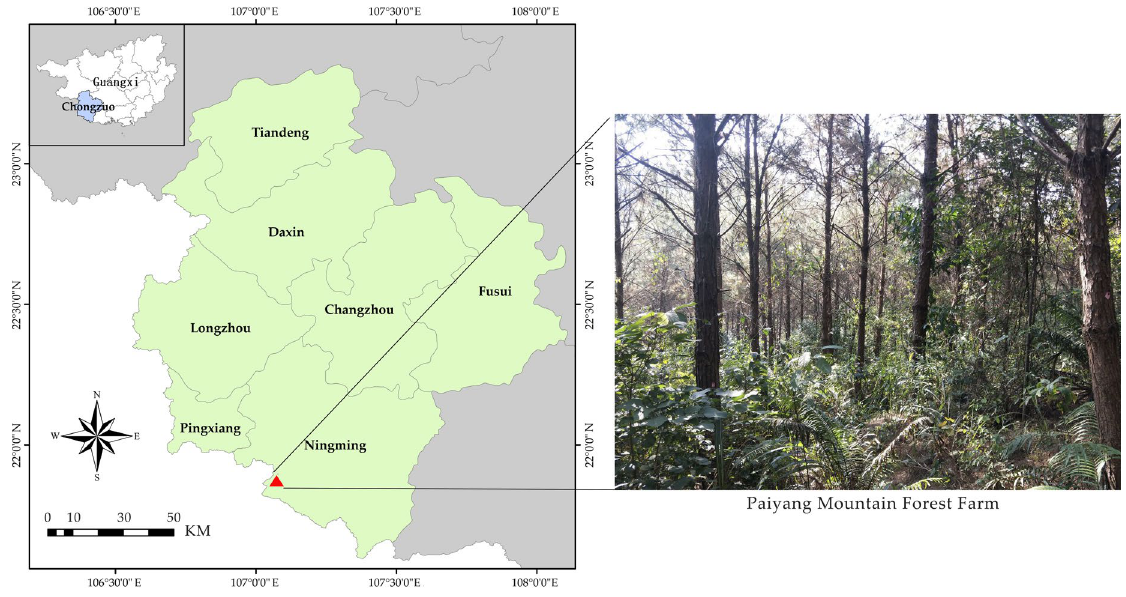
Figure 1. Distribution map of the northern tropical case study area.